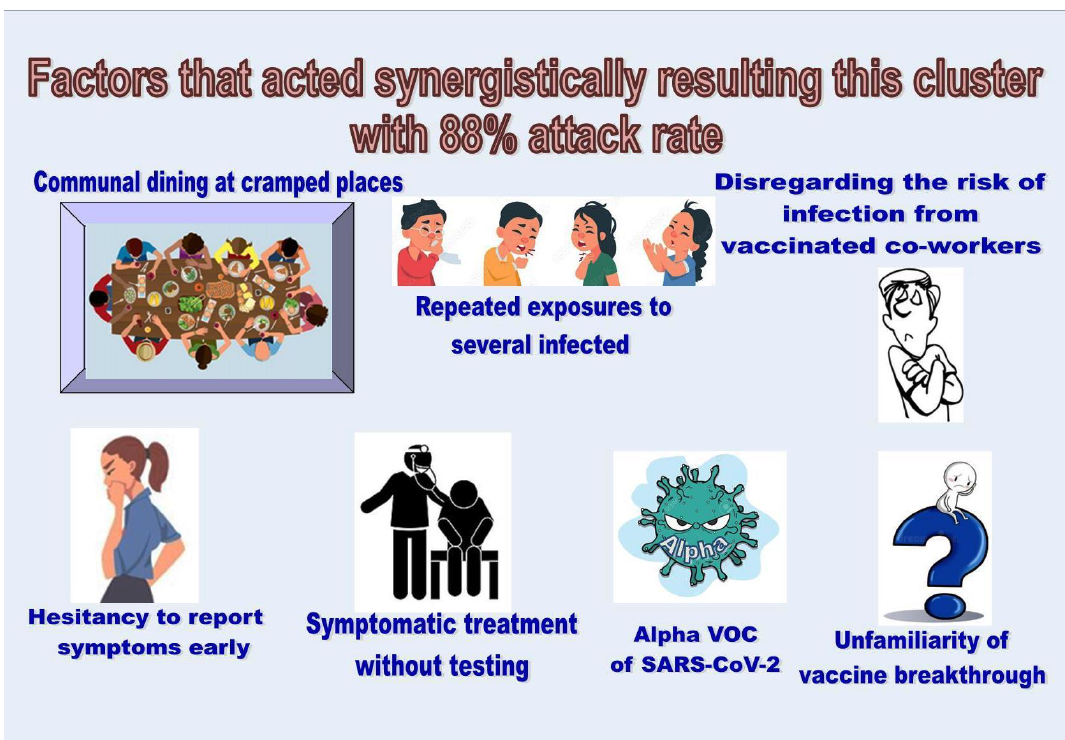
Figure 4. Factors that acted synergistically resulting in this outbreak with an 88% attack rate. At present, the local and global tendency is to relax non-pharmacological interventions for COVID-19 containment. A larger percentage of patients at hospitals have a weaker immune status compared to the general population and are thus susceptible to severe infections even from a few infectious HCW. Further studies will be helpful to determine the best and safest time to withdraw basic COVID-19 control measures at hospitals. Communal dining should be discouraged at workplaces with a high risk of COVID-19 transmission until the present pandemic is under control. Many experts are now (2023) aware of the individual factors that have led to this cluster as risk factors that are conducive to COVID-19 transmission. However, knowing that this particular combination of factors acted synergistically and that this sequence of events resulted a vaccine breakthrough COVID-19 cluster with an attack rate as high as 88% (35/40) will be useful in preempting similar clusters of COVID-19 and similar infections (especially respiratory infections with high basic reproduction numbers) in the